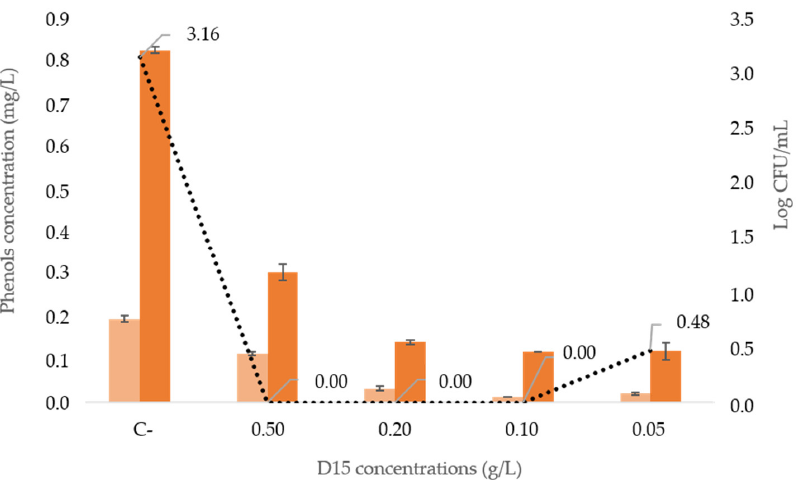
Brettanomyces yeasts, with the exception of the lowest dilution, where a slight Brettanomyces population survived. Similarly, ethyl phenols significantly decreased if compared with the untreated control (C-).